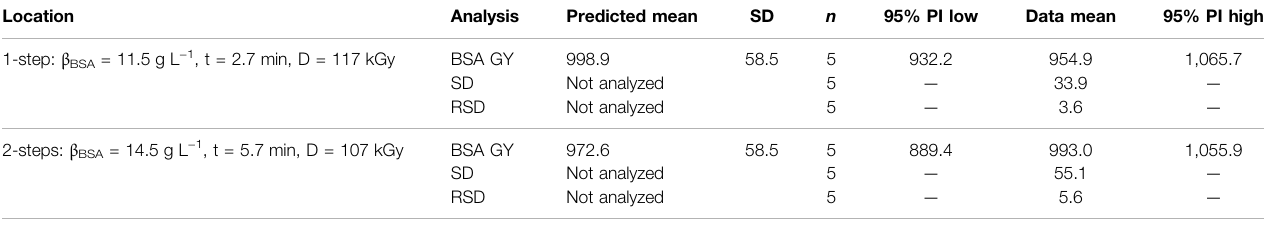
TABLE 6 | Con fi rmation of response models (RSM, I-optimal design). Two settings were examined (optimum for 1-step, and 2-steps method). The data mean was compared to the predicted mean and the 95% prediction interval (PI). Responses SD and RSD could not be analyzed since no model could be established (see text). Location